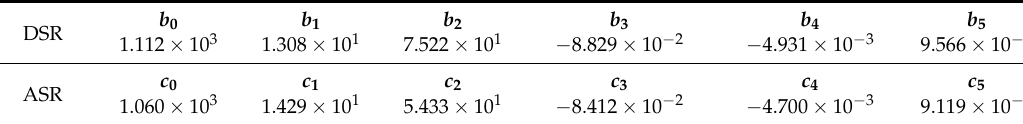
Table 3. Regression coefficients for calculating DSR and